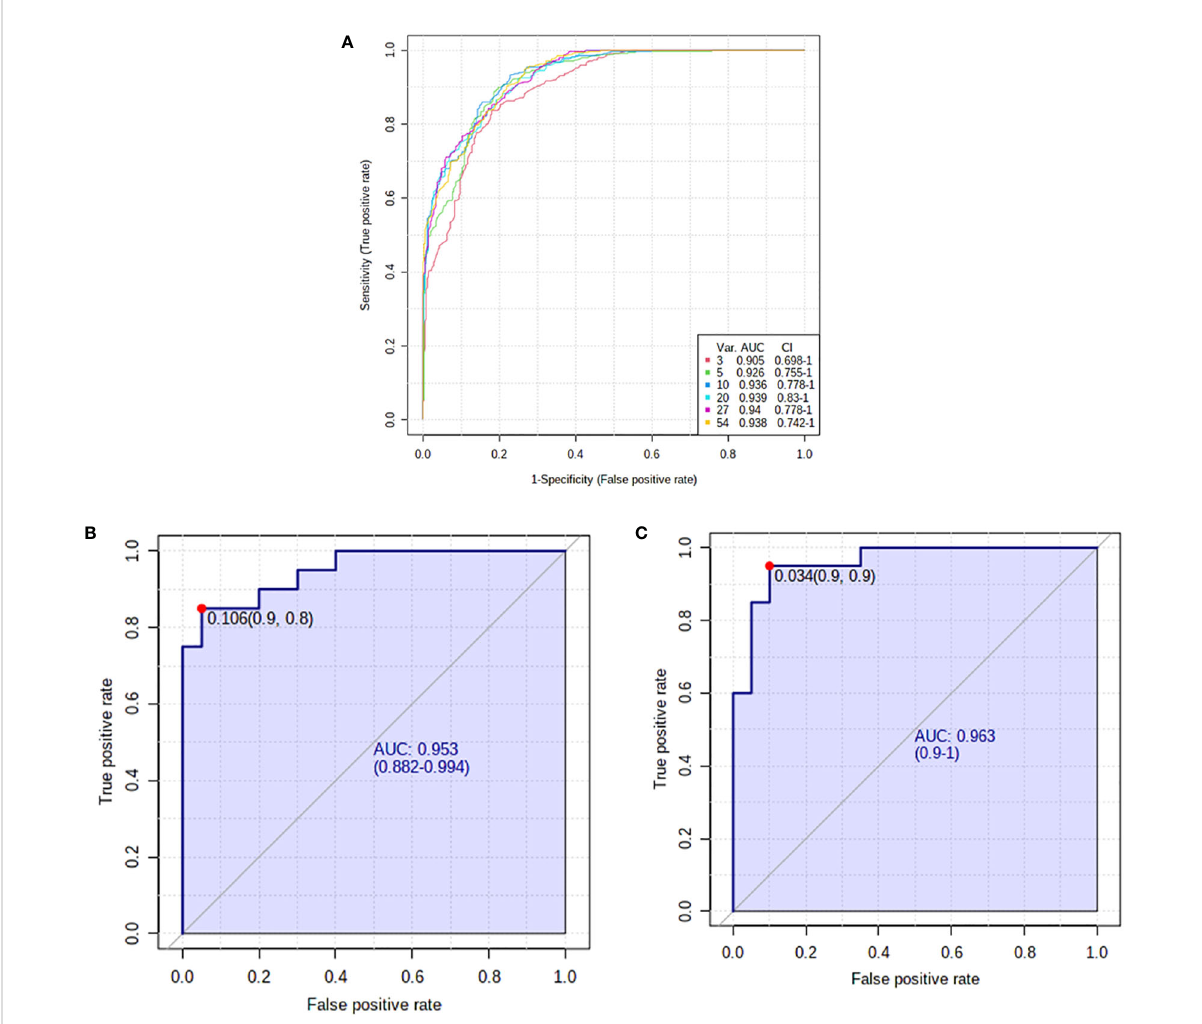
FIGURE 4 Receiver operating characteristics (ROC) curve and loading for signi fi cantly altered metabolites in pre- and post-hyperthyroid drug administration. (A) The PLS-DA model produced a ROC with an area under the curve (AUC) of at least 0.905 for the top 6 variants. (B) L-kynurenine (AUC-0.953) and (C) 3-O-Methylguanosine (AUC-0.963) were downregulated in post-treatment group. The median, log-transformed, and Pareto normalized data scaled to con fi rm that all depicted data has a Gaussian